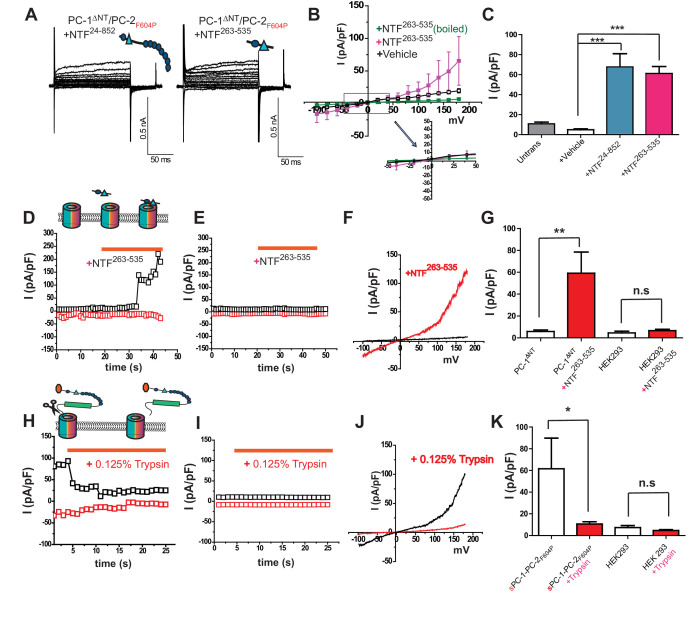
Polycystin activation depends on the C-Type lectin domain.(A) Representative whole cell currents of PC-1ΔNT/PC-2F604P after application of PC-1 NTF24-852 (left) or NTF263-535 (right). (B) I-V relationships of PC-1ΔNT/PC-2F604P with addition of NTF263-535 (n = 6, pink), PC-1ΔNT/PC-2F604P with addition of heat-inactivated fragment (n = 8, black), and PC1ΔNT/PC-2F604P alone (n = 8, green). (C) Current densities of untransfected cells (gray) and PC-1ΔNT/PC-2F604P after addition of control medium (n = 7, white), NTF24-852 (n = 5, blue) and NTF263-535, (n = 6, pink). ***, p<0.001. (D) Time course of PC-1ΔNT/PC-2F604P transfected cells in response to NTF263-535. Currents are recorded at +180 mV (black) and −100 mV (red). Orange bar indicates addition of NTF. (E) Time course of untransfected cells in response to NTF263-535. Conditions are identical to D. (F) I-V relationships obtained by voltage ramp pulse for PC-1ΔNT/PC-2F604P before (black) or after (red) NTF263-535 application. (G) Current densities at +100 mV potential from PC-1ΔNT/PC-2F604P (n = 7) or untransfected cells (n = 9) before (blank) or after application (red) of NTF263-535. (H) Time course of sPC-1/PC-2F604P transfected cells in response to application of 0.125% trypsin. Currents are recorded at +180 mV (black) and −100 mV (red). Orange bar indicates addition of trypsin. (J) I-V relationships for sPC-1/PC-2F604P before (black) and after (red) 0.125% trypsin application. (K) Current densities at +100 mV potential from for sPC-1/PC-2F604P (n = 6) and untransfected cells (n = 5) before (blank) or after (red) 0.125% trypsin application.